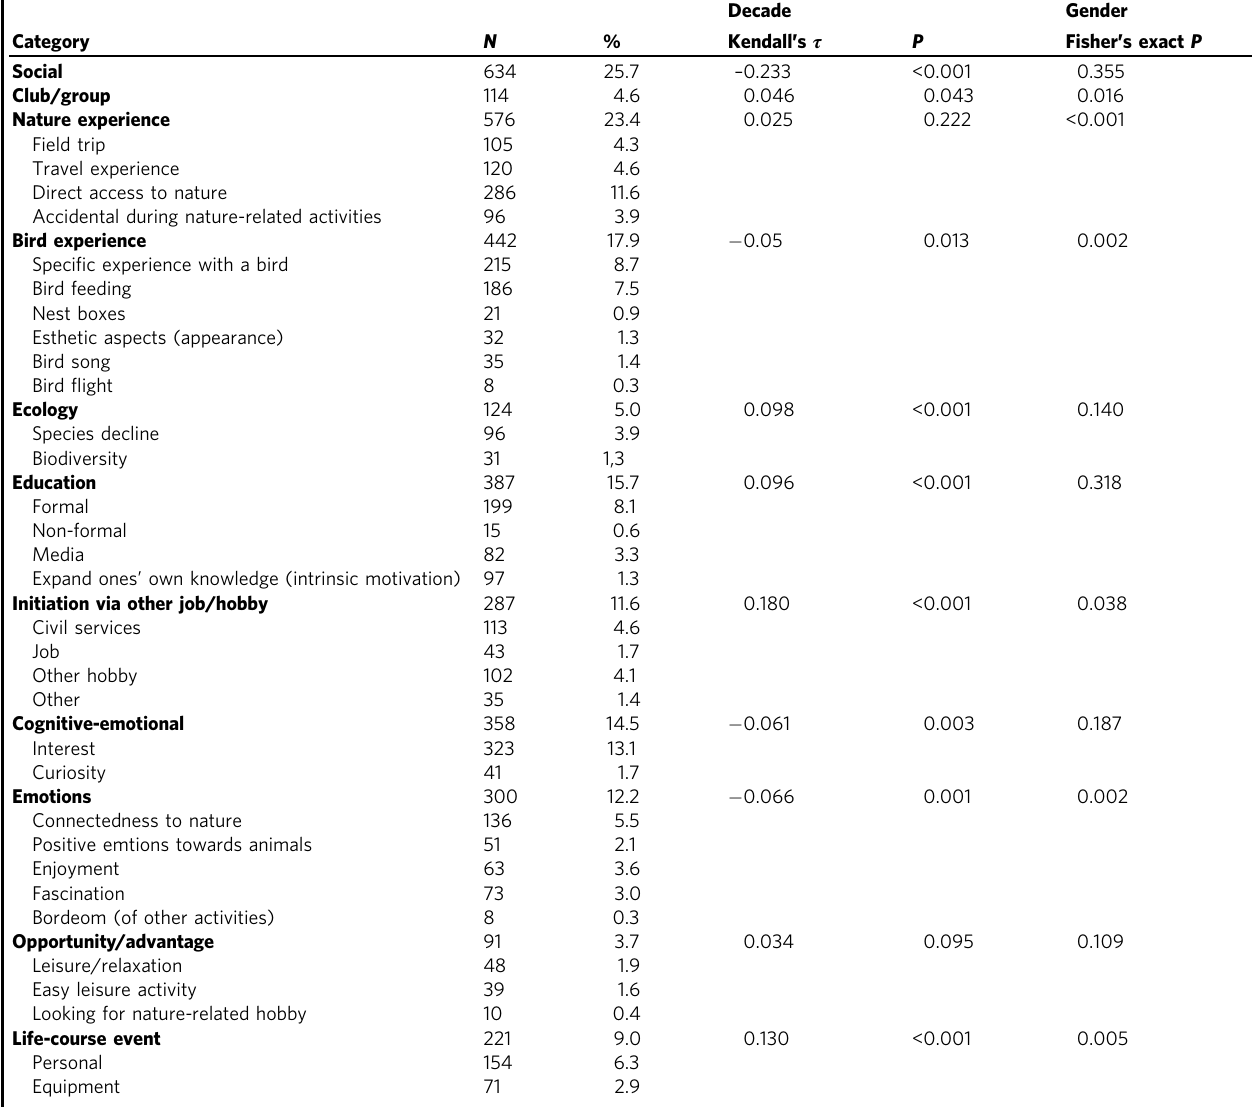
Table 1 Main categories (in bold) and subcategories for initial involvement into